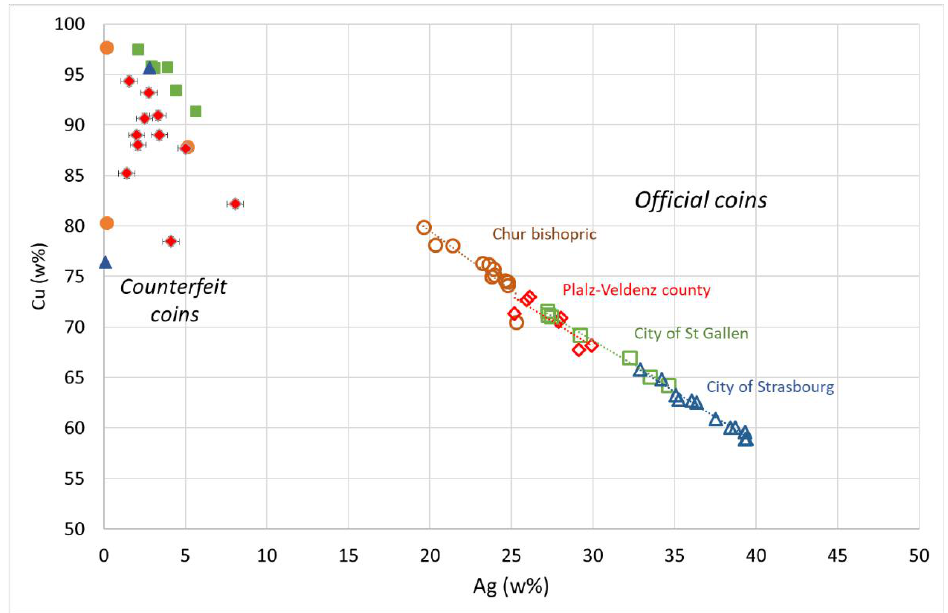
Figure 3. Silver vs. copper contents (in wt%) for selected coins of the Preuschdorf hoard coming from the cities of Strasbourg and St. Gallen, the county of Pfalz-Veldenz, and the bishopric of Chur. Open symbols correspond to official coins, and filled symbols correspond to counterfeit coins.